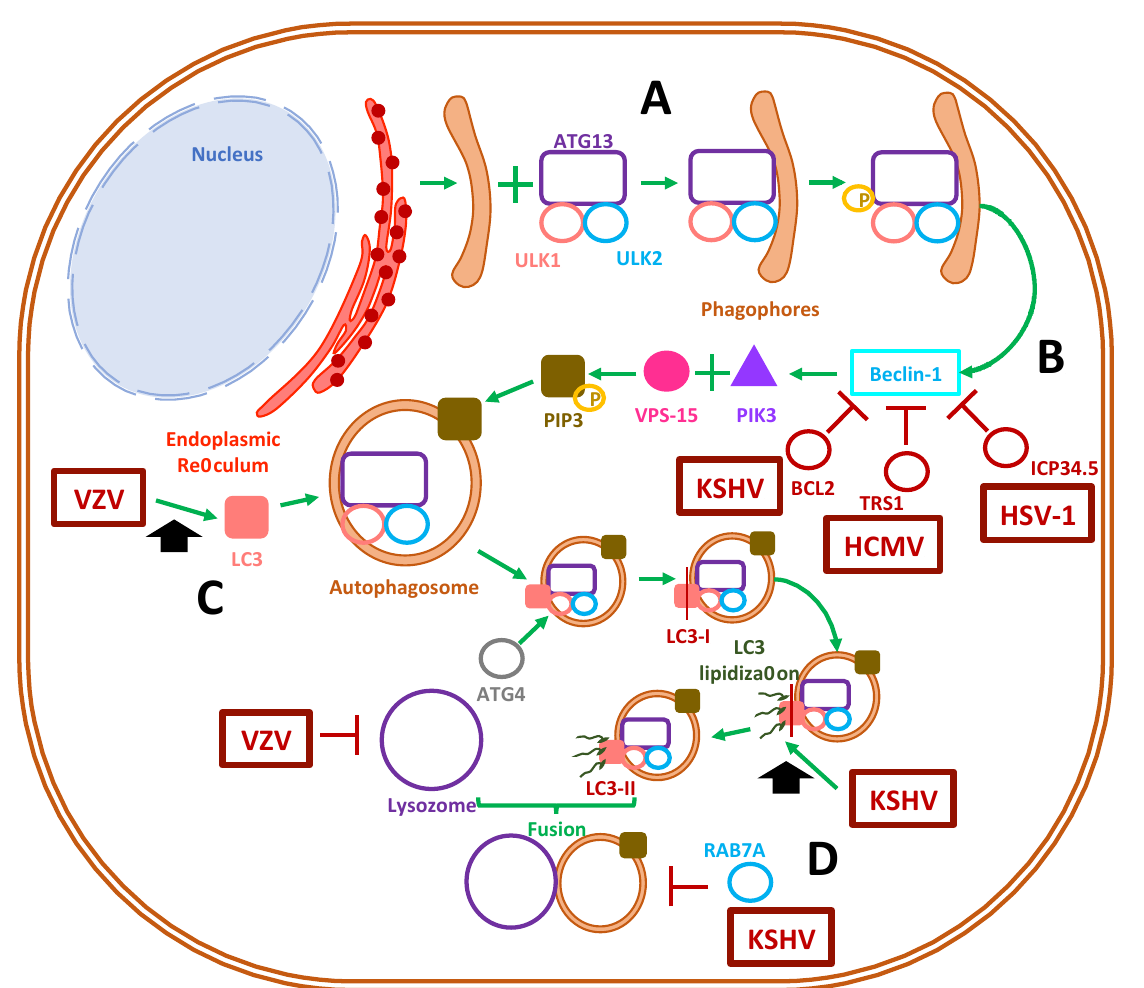
Figure 2. Modulation of autophagosome formation by herpesviruses. ( A ) Autophagosome formation in mammalian cells begins with the materialization of the phagophore, together with the recruitment of host proteins autophagy-related protein 13, ULK1 and ULK2. ( B ) Afterward, ULK1 phosphorylation activates the beclin-1 protein and triggers the recruitment of proteins that finally recruit the class-III phosphatidylinositol-3 kinase to the autophagosome membrane. The activation of beclin-1 is inhibited by the viral proteins BCL2, TRS1 and ICP34.5 of Kaposi’s sarcoma-associated herpesvirus (KSHV), human cytomegalovirus (HCMV) and herpes simplex virus (HSV), respectively. ( C ) The early autophagosome recruits the LC-3 protein, a process that is enhanced by VZV, which triggers the maturation of the autophagosome due to the lipidation of LC-3 into LC-3-II. The latter step has been shown to be enhanced by KSHV. ( D ) Ultimately, autophagy concludes with fusion of a mature autophagosome with a lysosome. This process has been shown to be inhibited by VZV and the protein RAB7A by KSHV.